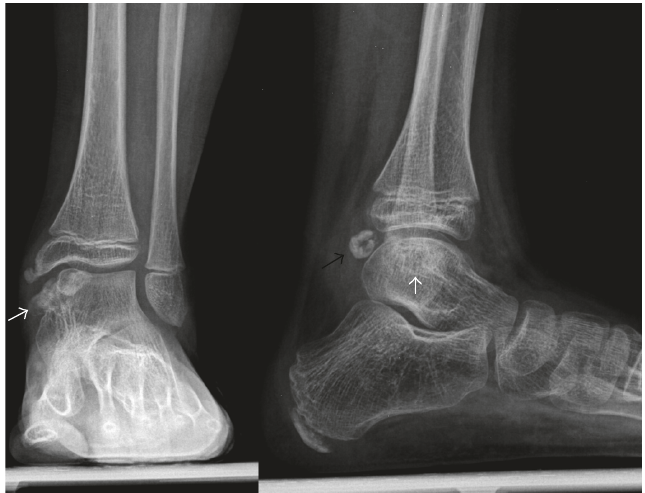
Figure 6: X-rays show medial talus and tibia bony formations (white arrows) and posterior cauliflower fashioned loose body (black arrow).